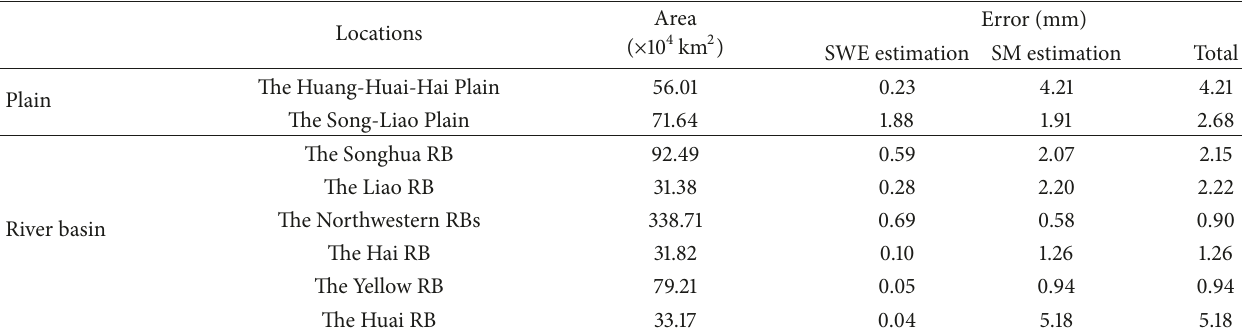
Table 5: Errors estimation from four land surface models in different places of Northern